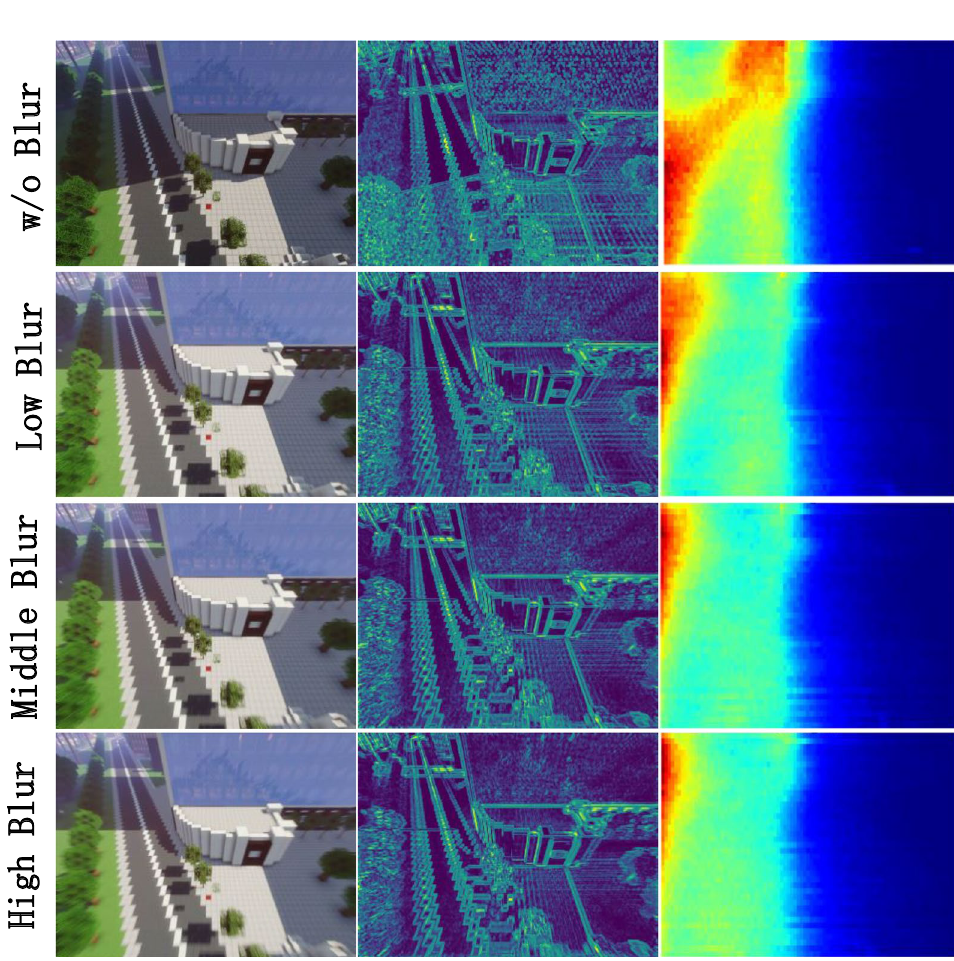
70 m) a histogram statistical result of the inter-frame error and its ≤